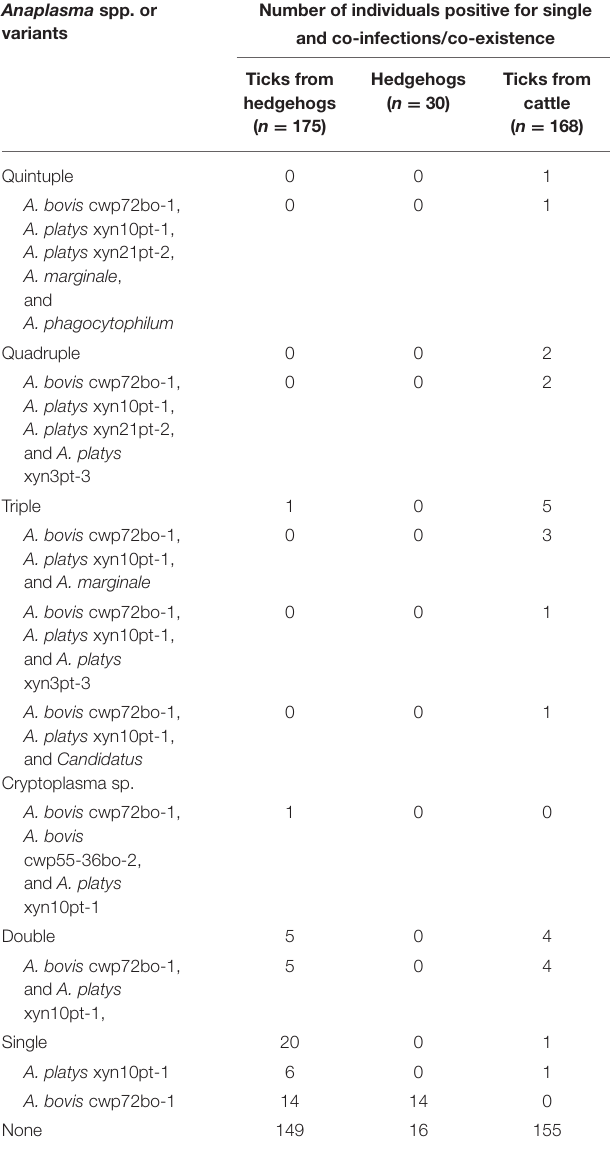
TABLE 2 | Co-existence/co-infections of various Anaplasma spp. or variants in various samples. Anaplasma spp. or